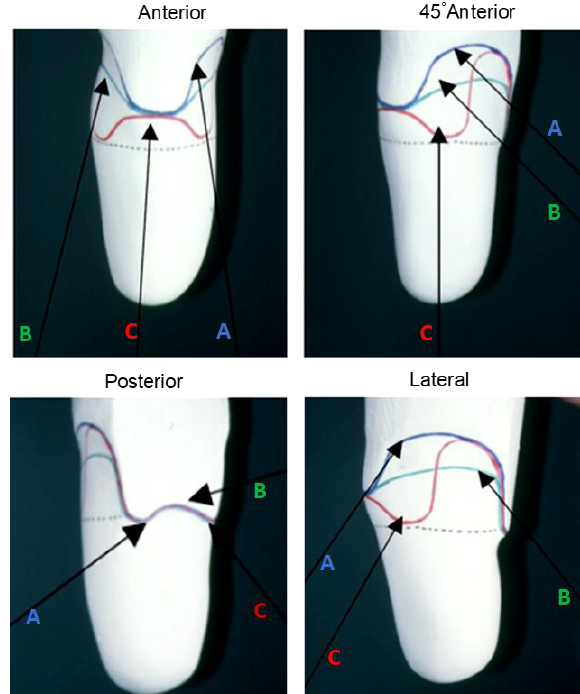
Figure 2: Images illustrating the anterior, 45° anterior, posterior view as well as lateral views of the SOL style positive plaster model. Where ( A ) indicates trim lines for supracondylar suspension, ( B ) trim line for a PTB type socket with cuff suspension, and ( C ) trim line for a Söderberg type